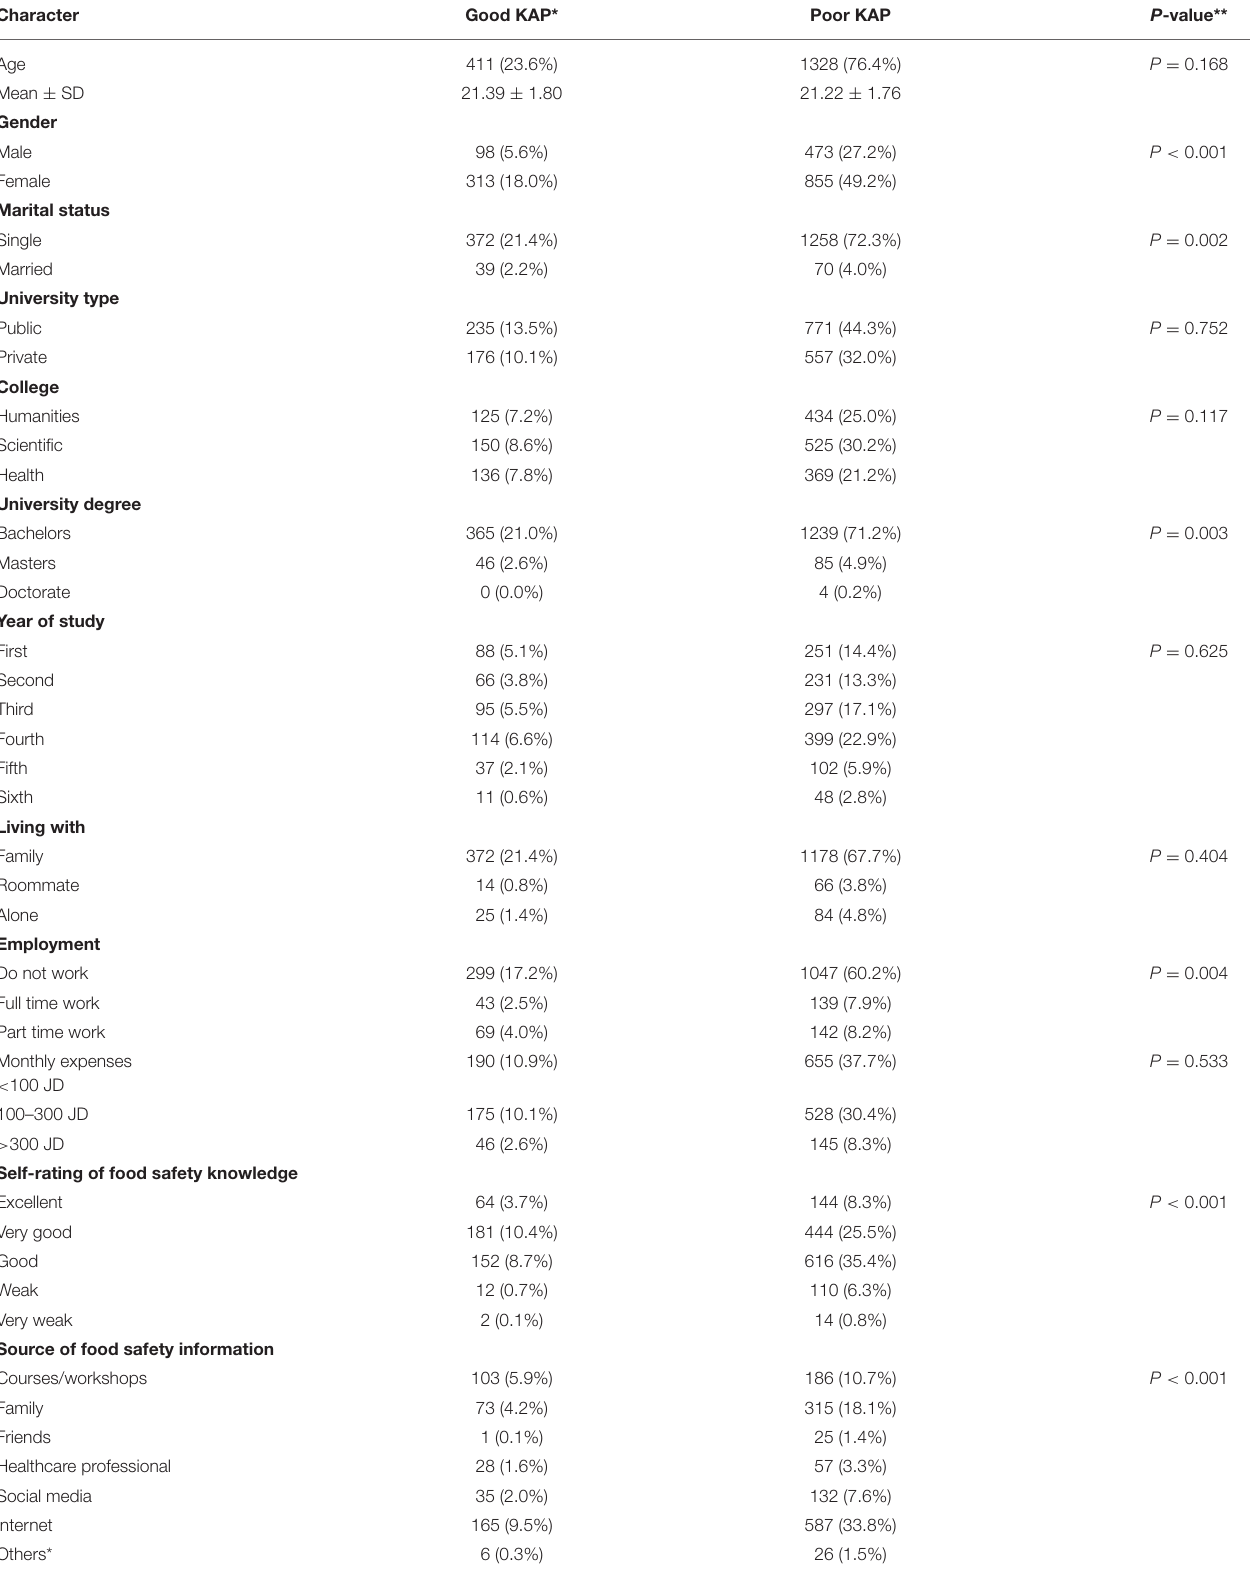
TABLE 7 | Association between food safety knowledge, attitudes, and practices scores and general characteristics of university students. Character Good